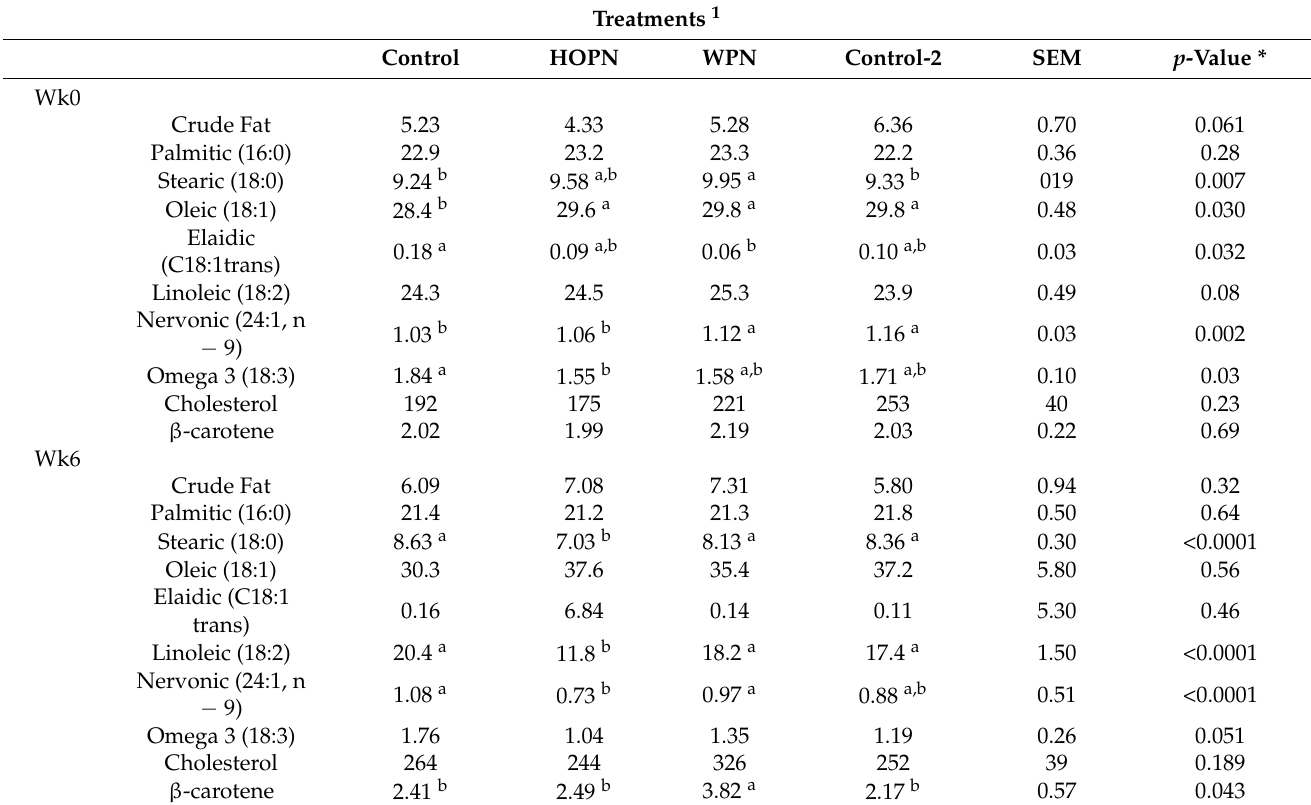
Table 7. The β -carotene, lipid and fatty acid analysis of eggs produced from hens fed a control or peanut-containing diet.